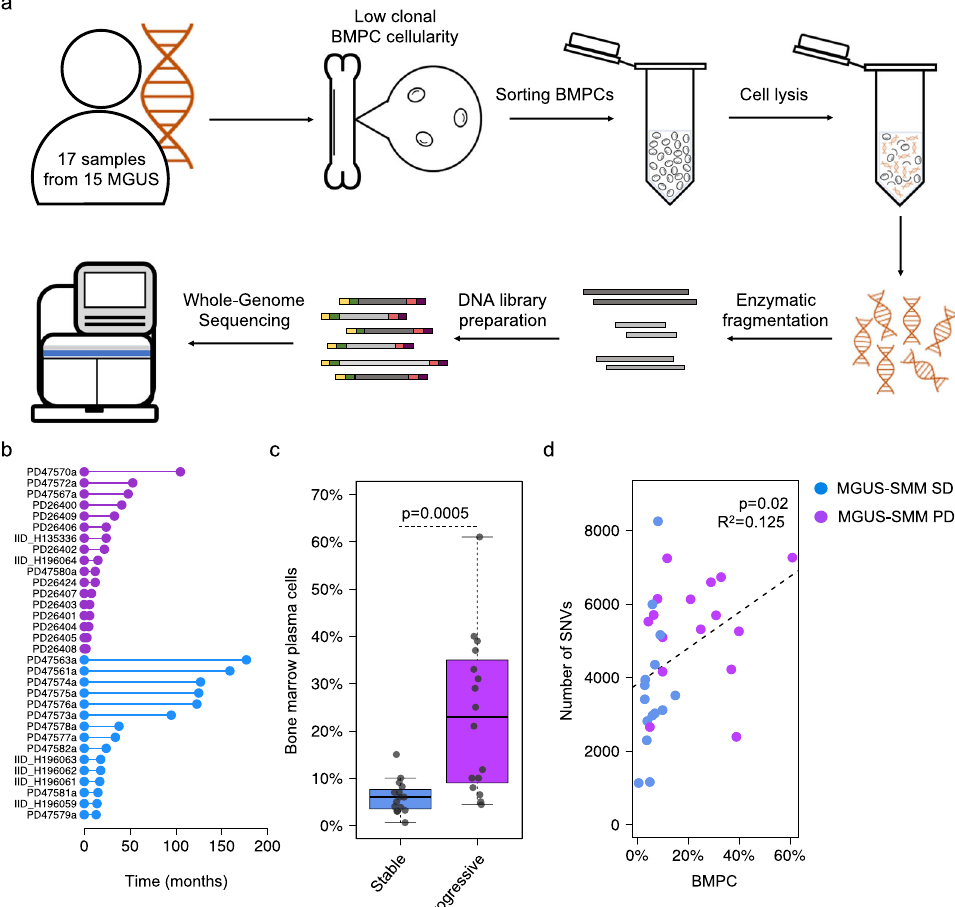
Fig. 1 Summary of all patients with myeloma precursor condition included in the study. a A cartoon summarizing the low-input whole-genome sequencing approach. b Follow up time for all patients with myeloma precursor condition included in the study. Purple and blue lines and dots re fl ect patients that progressed to multiple myeloma (MM; N = 17) and hadn ’ t had progression ( N = 15) at the time of study, respectively. c Comparison of bone marrow plasma cell in fi ltration between stable and progressive myeloma precursor condition. p value was generated using Wilcoxon rank-sum test. Boxplots show the median and interquartile range. d Correlation between bone marrow plasma cell (BMPC) in fi ltration and single nucleotide variants (SNV) burden in myeloma precursor condition. p value and R 2 were estimated using lm R function (linear regression). MGUS: monoclonal gammopathy